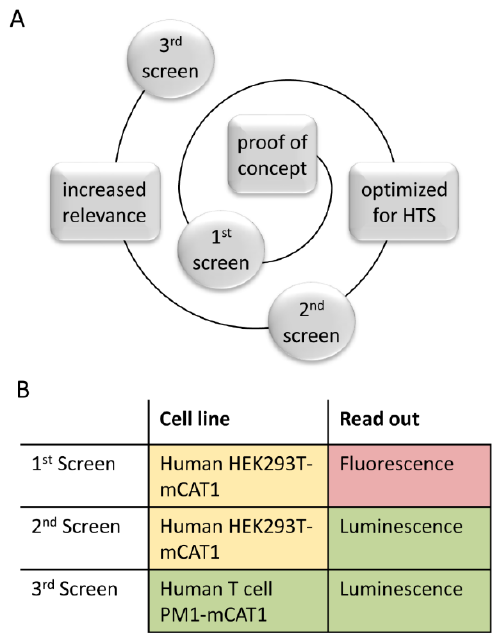
Figure 4. Overview of the assay methodology development. ( A ) Representation of the assay development based on incremental improvement. ( B ) Comparison of the screening methodology in terms of relevance, based on a traffic light system.